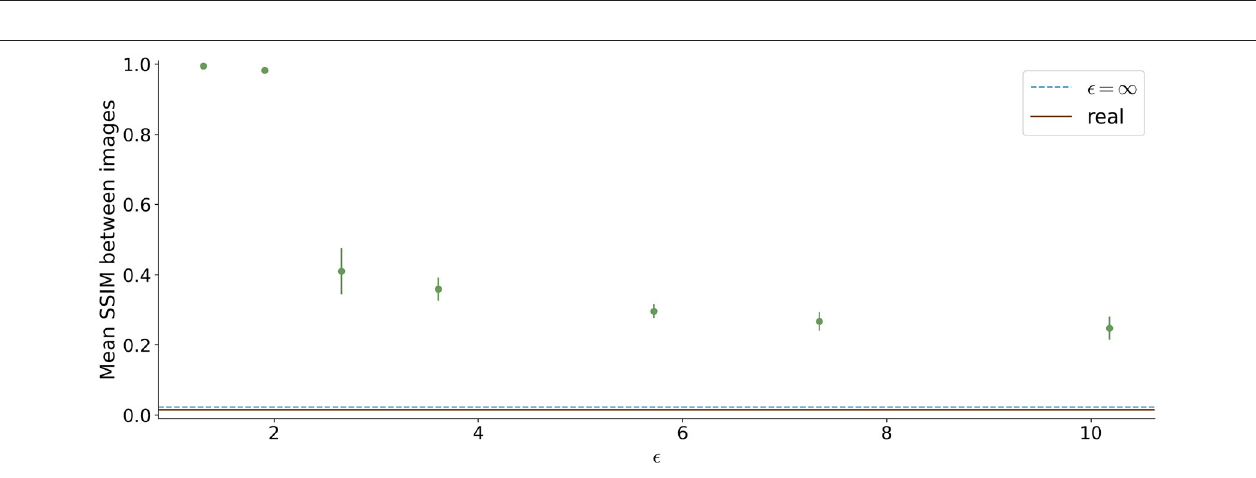
FIGURE 8 | Mean Structural Similarity Index Measure (SSIM) between 1,000 generated images for differential ǫ values. The errorbar shows the standard deviation over the 5 different runs for each ǫ value. For ǫ < 2, the similarity between images is high, whereas it decreases for higher ǫ